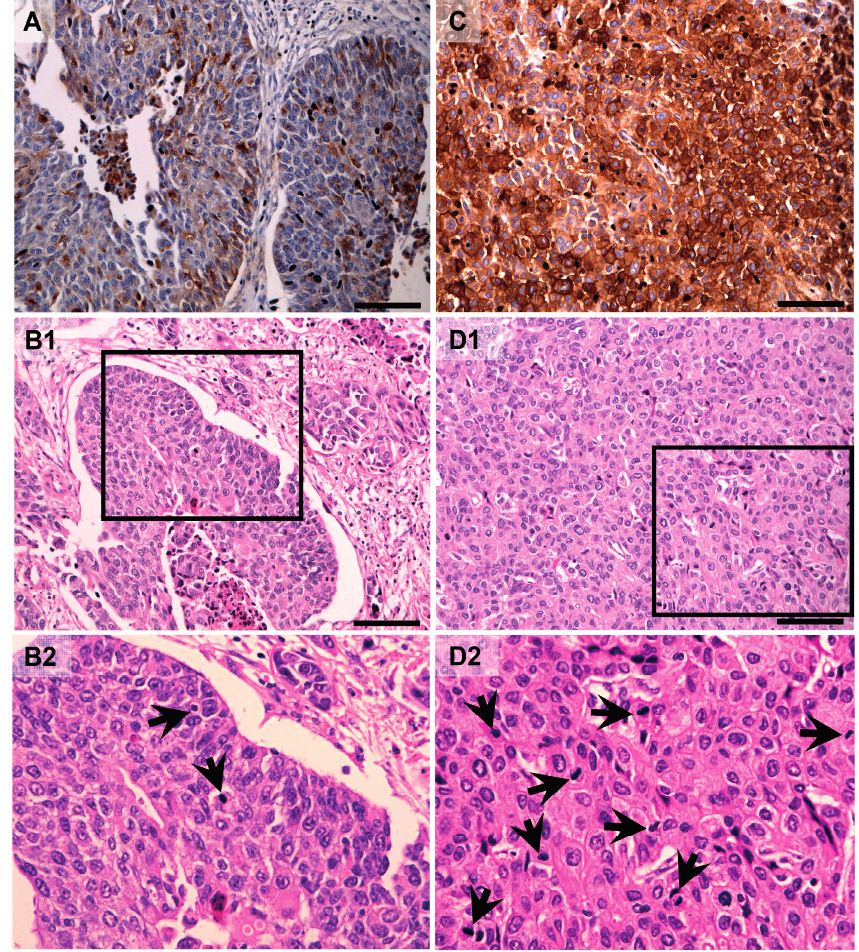
Figure 2. Representative RCAS1 immunolocalization in central parts ( A ) (low mitotic index, B-1 , B-2 ) and border parts ( C ) (high mitotic index, D-1 , D-2 ) of the tumors. Figure 2B-2 and 2D-2 present the fragments indicated by the black squares within Figure 2B-1 and 2D-1, respectively. Arrows indicate mitosis. Scale bars: 100